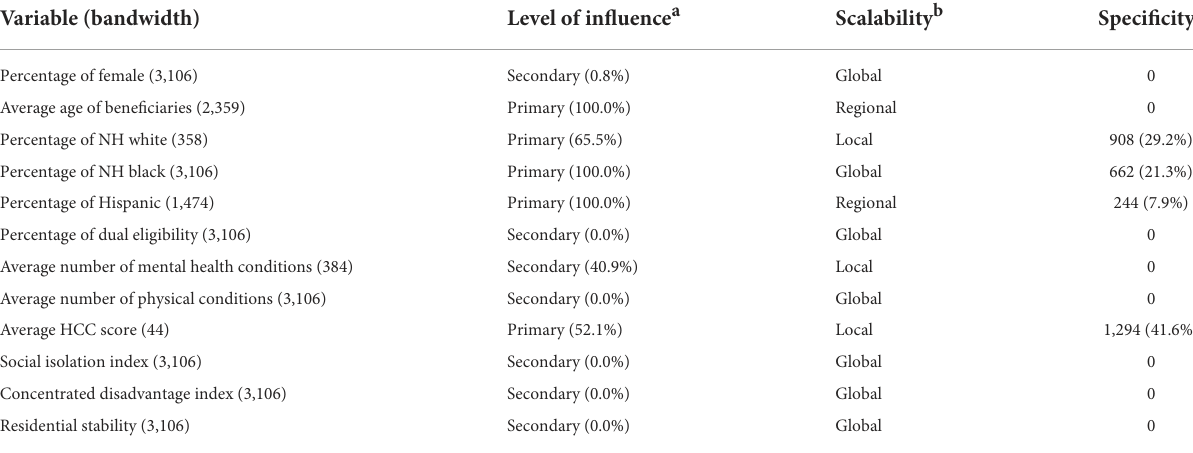
TABLE 3 Three Dimensions of Multiscale Spatial Process for Each Independent Variable Based on the MGWR